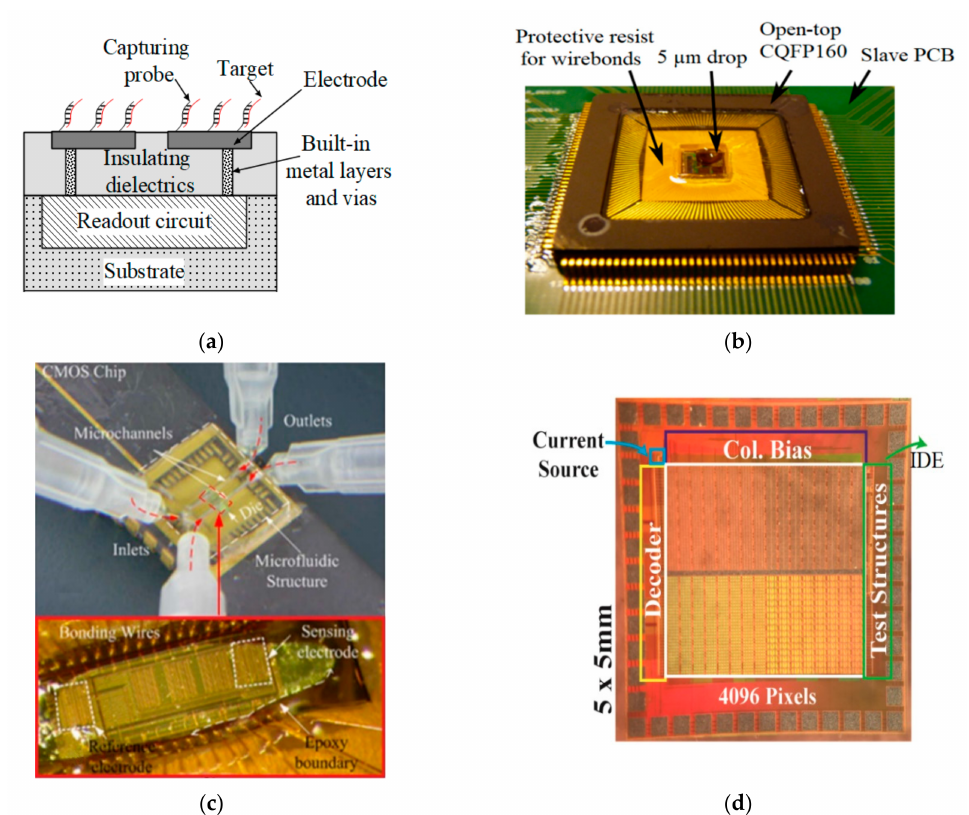
Figure 9. ( a ) Interfacing techniques for electrochemical sensing; ( b ) Packaged CFC chip proposed in [91]; ( c ) A capacitive sensor chip packaged by DWFP technique proposed in [28]; ( d ) The photograph of the 64 × 64 redox amplified coulostatic discharge-based biosensor array reported in